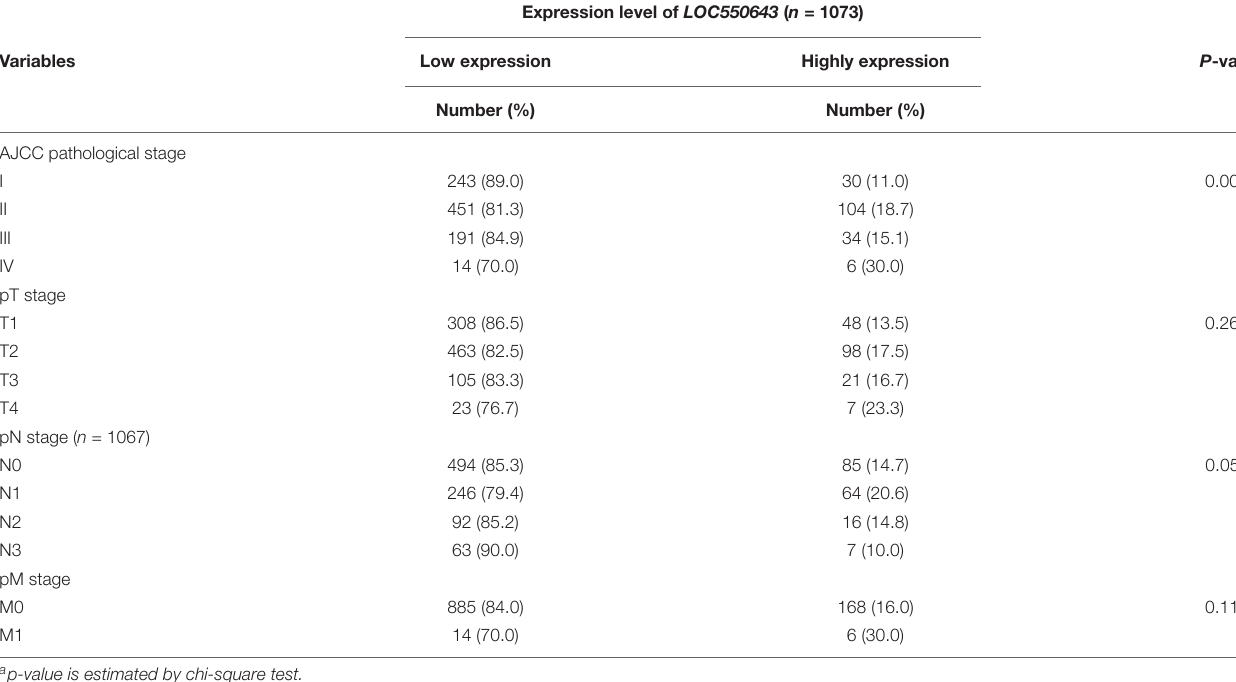
TABLE 1 | The relationship between expression levels of LOC550643 and clinicopathologic data of BC patients. Expression level of LOC550643 ( n = 1073)